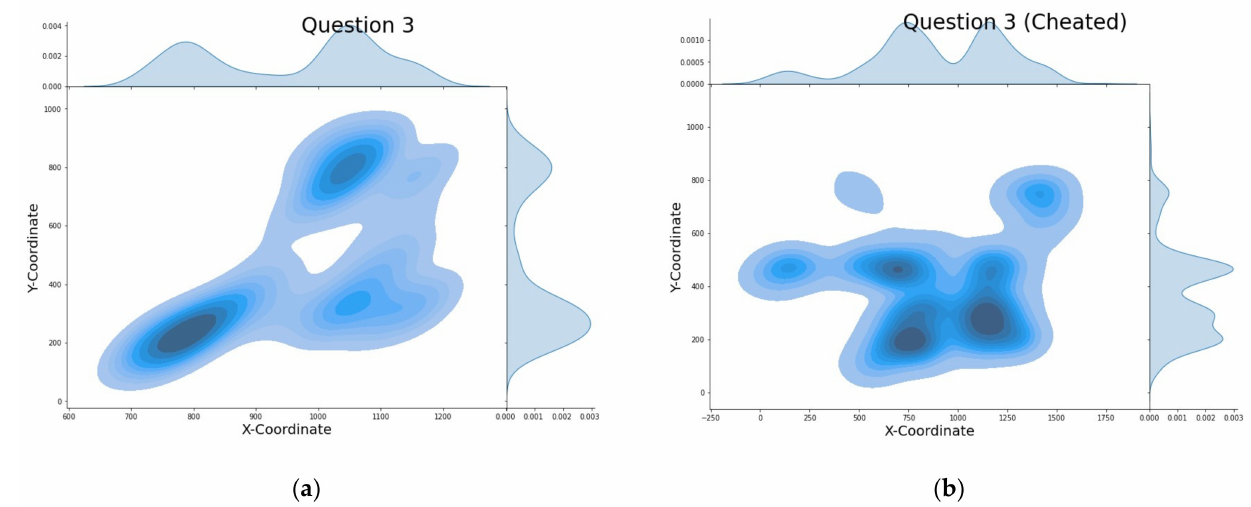
Figure 7. 2-d KDE plot showing the density distribution of raw mouse cursor movements of students as follows: ( a ) a KDE plot of question 3 answered by students without cheating; ( b ) a KDE plot of question 3 answered by students who are allowed to cheat.